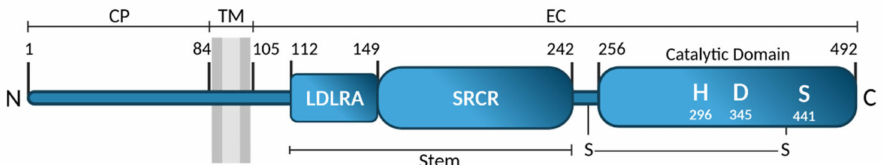
Figure 2. Architecture of TMPRSS2. CP: cytoplasmatic domain; TM: transmembrane domain; EC: extracellular domain; LDLRA: low density lipoprotein receptor class A domain; SRCR: scavenger receptor cysteine-rich domain; H, D, S: catalytic triad (histidine, aspartate, serine); N and C: N- and C-terminus, respectively. S-S indicates disulfide bridge (note that only the disulfide bridge between the catalytic and SRCR domains is shown, with the remaining disulfide bridges omitted for clarity). Numbers indicate amino acid position according to UniProt O15393. Figure created with BioRender.com (accessed on 13 December